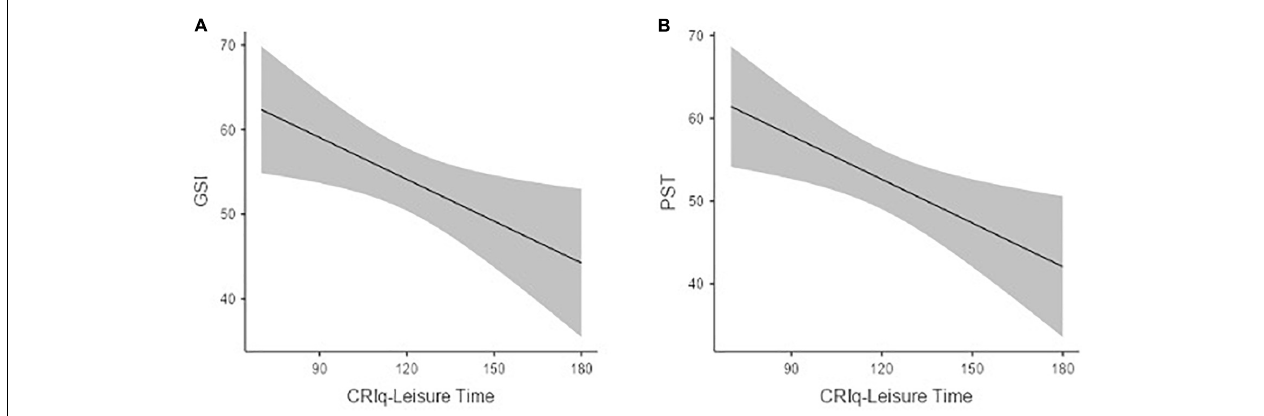
FIGURE 1 | The association between CRIq-leisure time score and the SCL-90. Global severity index (A) and positive symptom total (B)